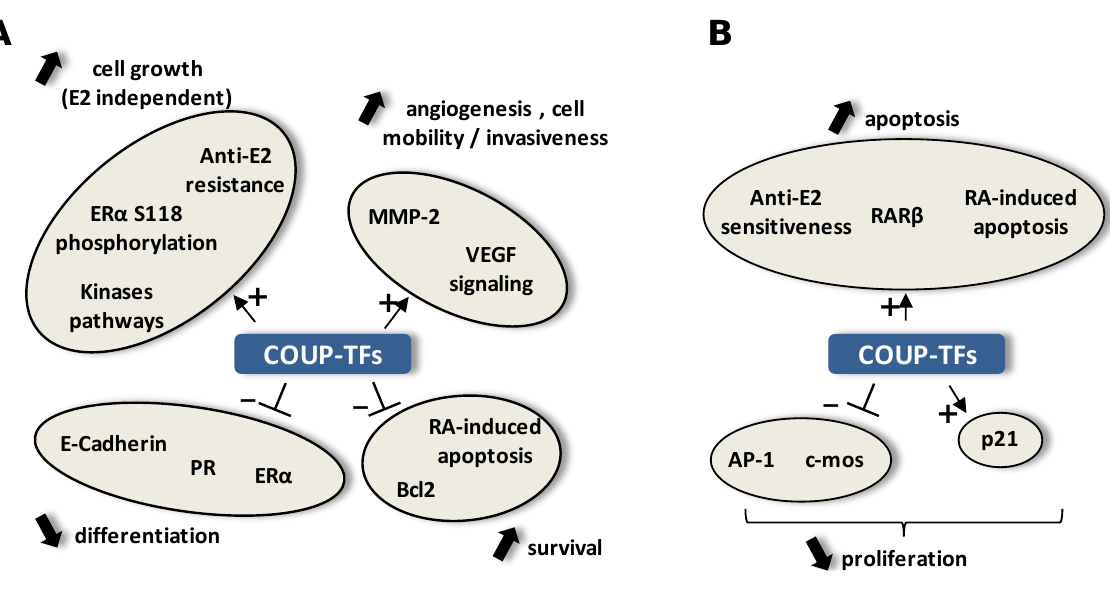
Figure 3. Identified-targets of COUP-TFs described in cancer progression or